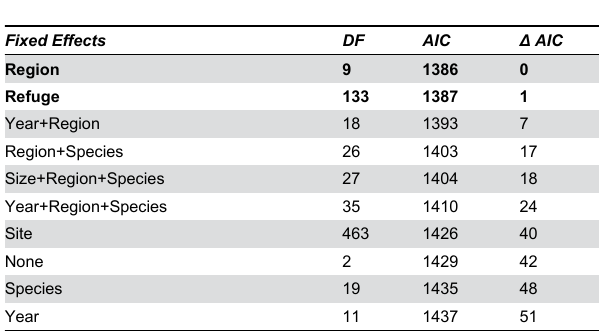
Table 1. Model comparison for factors potentially influencing skeletal and eye abnormalities.